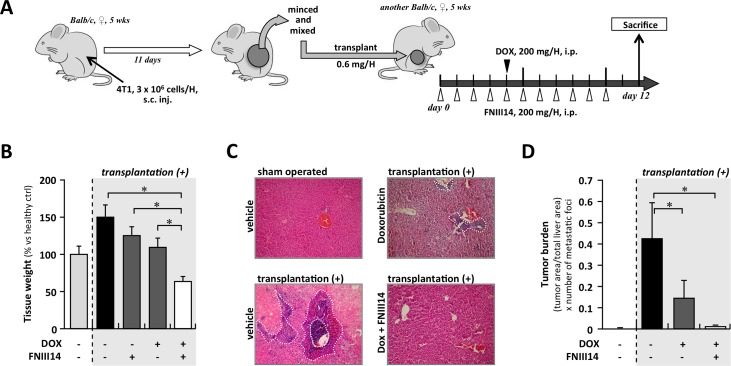
Combination therapy using FNIII14 and doxorubicin in mouse mammary tumor metastasis model.(A) The schematic illustration of experimental schedule. (B) Liver weight at day 12 after tumor graft implantation was shown in bar graph. Data were shown as means ± S.D. *; p<0.05 vs Dox(-)/FNIII14(-) animals. (C) Representative image of paraffin-embedded tissue section with hematoxylin-eosin staining. Metastatic tumor lesion was circled by broken white line. (D) Tumor burden was calculated as [(tumor area / total tissue area) / number of metastatic foci].